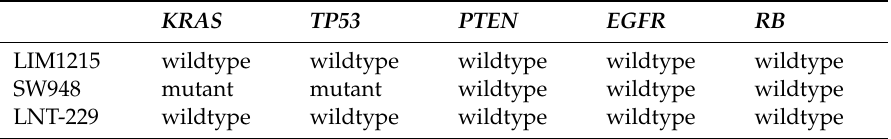
Table 1. Mutational status of KRAS, TP53, phosphatase and tensin homolog (PTEN), epidermal growth factor receptor (EGFR), and retinoblastoma (RB) genes (Cancer Cell Line Encyclopedia, https: // portals. broadinstitute.org / ccle